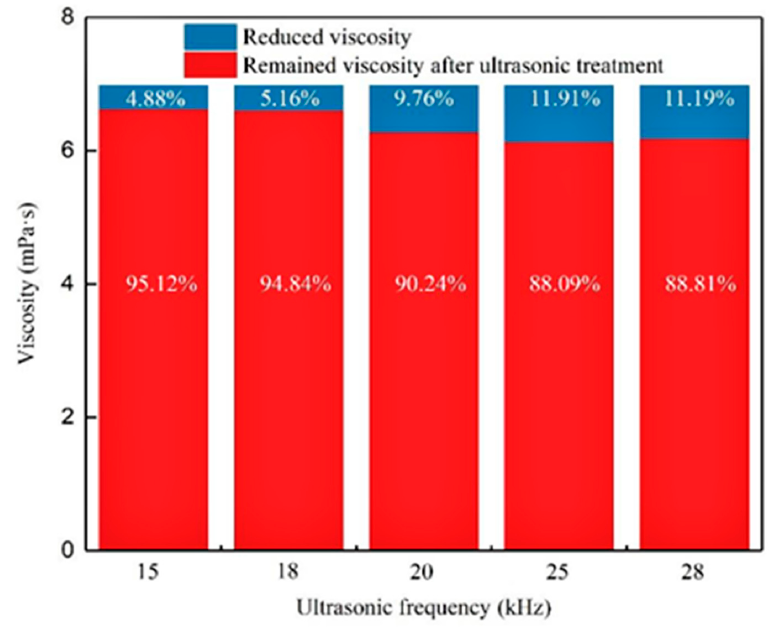
Figure 1. How different frequencies of ultrasonic waves affect the lowering of viscosity (Reprinted from Li et al . , [9] Copyright 2020, under the CC BY-NC-ND license, http://creativecommons.org/li- censes/by-nc-nd/4.0/, (accessed on 9 June 2022). Again, ultrasonic waves of varied frequencies were used to investigate brine–oil in- terfacial tension (IFT), and Figure 2 depicts the variation in IFT produced by the ultrasonic treatment. In terms of lowering the interfacial tension, ultrasonic waves with frequencies of 25 and 28 kHz were more effective than frequencies of 15 and 18 kHz.